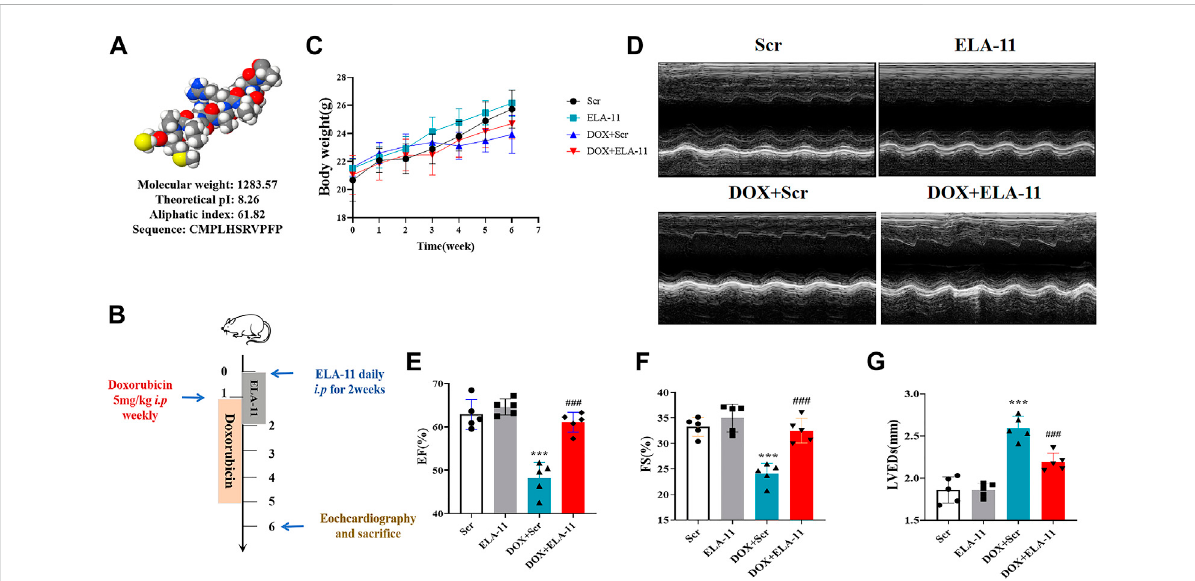
Function of ELA-11 in doxorubicin-injured model. (A) The biological characteristics of ELA. (B) Schematic map for DOX-induced mice cardiac injury model. (C) The body weight of mice in four groups during the experiment. (D) The representative echocardiograms of DOX-induced cardiac injured group. (E) EF value for echocardiography. (F) FS value for echocardiography. (G) LVEDs value for echocardiography. *** p < 0.001 and ### p < 0.001, one-way ANOVA, N = 5 mice per